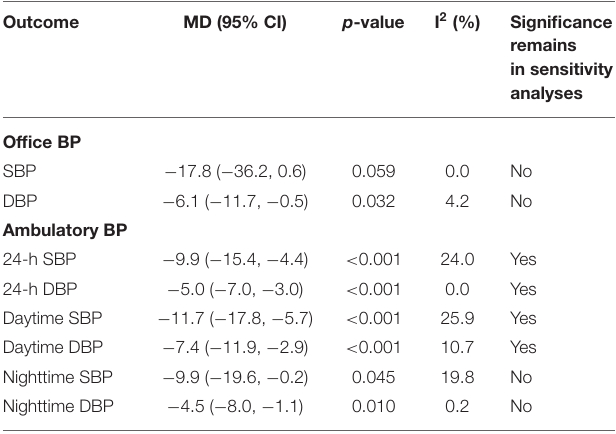
TABLE 2 | Pooled analysis of the effect of exercise training intervention on blood pressure (BP) measures in patients with resistant hypertension. exercise